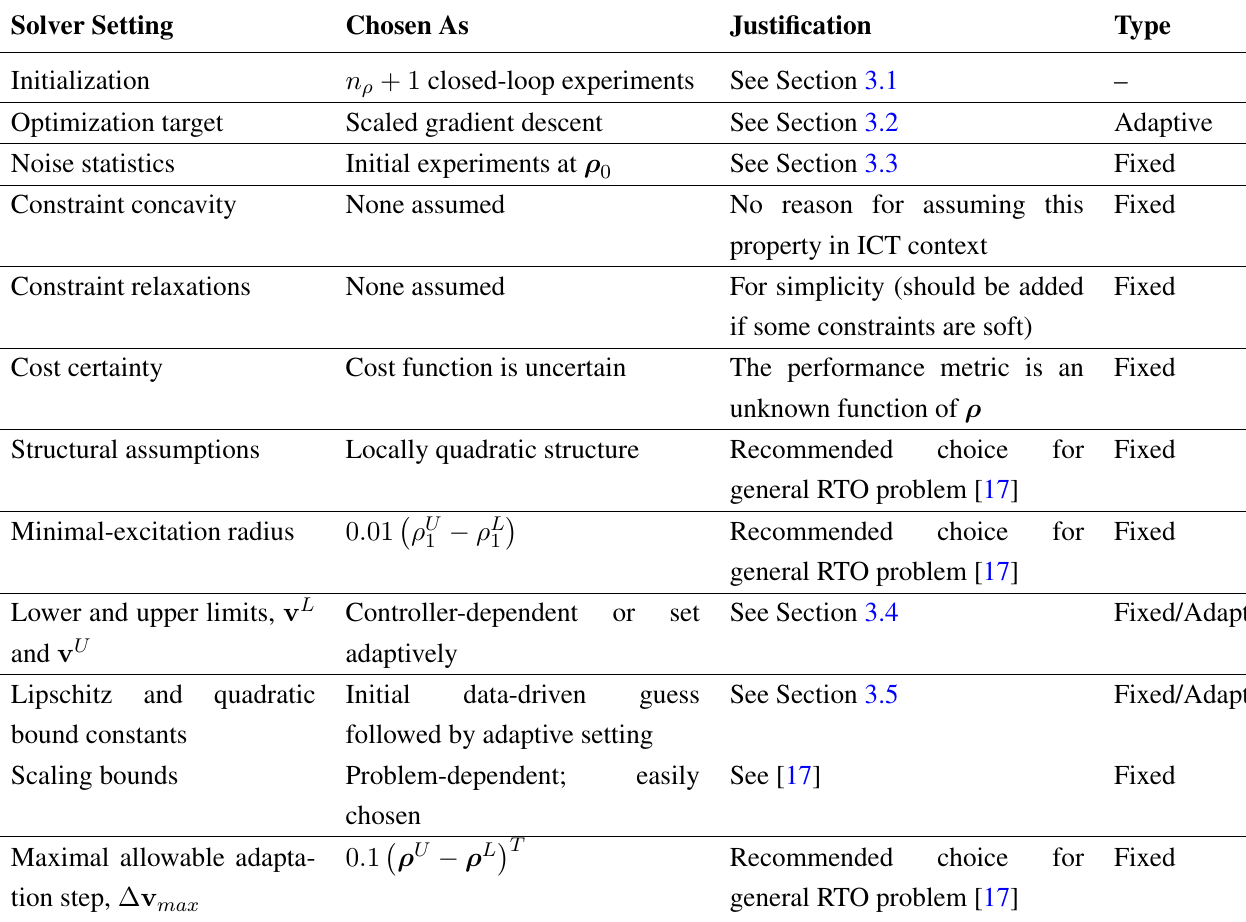
Table 1. Summary of SCFO configuration settings for the ICT